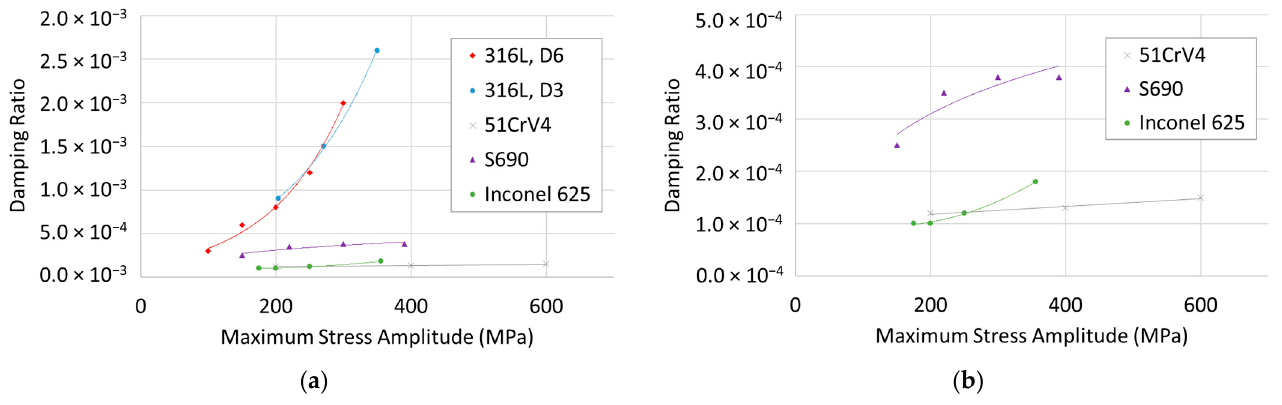
Figure 16. Measured average damping ratios for several stress amplitudes in UHCF specimens: ( a ) Measured damping for all materials; ( b ) Closer view, lower damping materials.